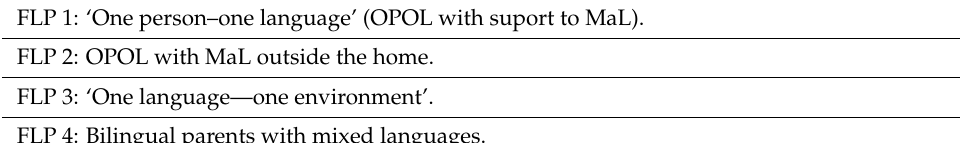
Table 3. Children’s Family Languages